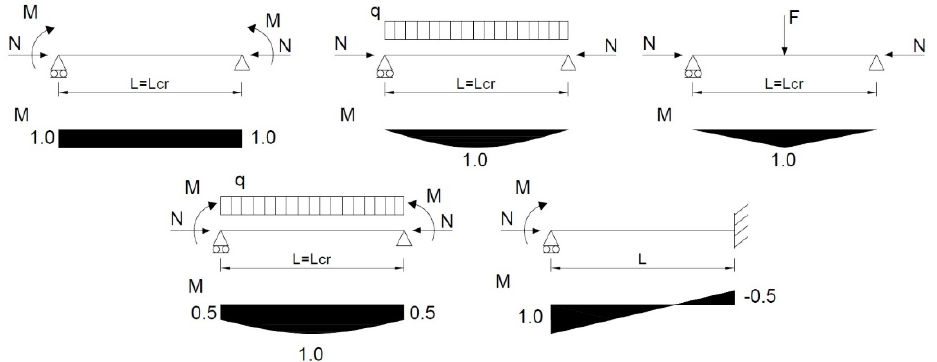
Figure 2. Load cases investigated in the numerical analysis.